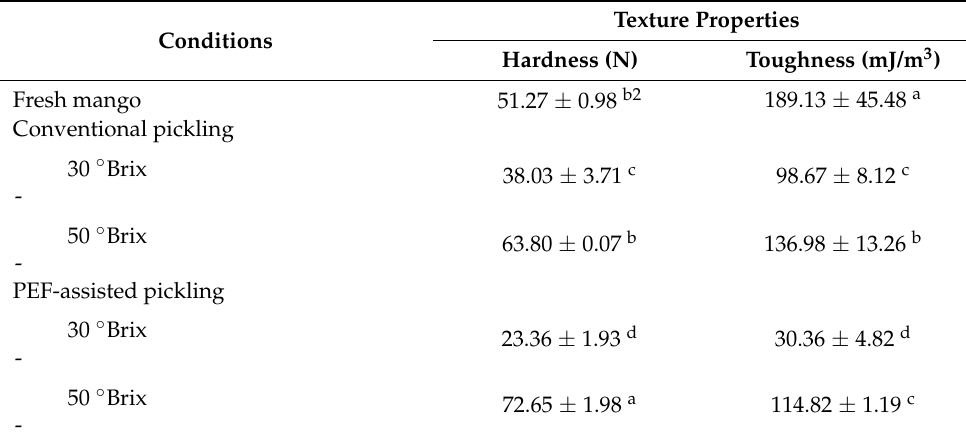
shows that a–d within the same column are statistically different at p < 0.05. 3 ns is non-significant difference ( p > 0.05). Table 3. Texture properties for the conventional and PEF-assisted pickling processes with 30 ◦ Brix and 50 ◦ Brix sucrose solutions (processing time = 24 h) 1